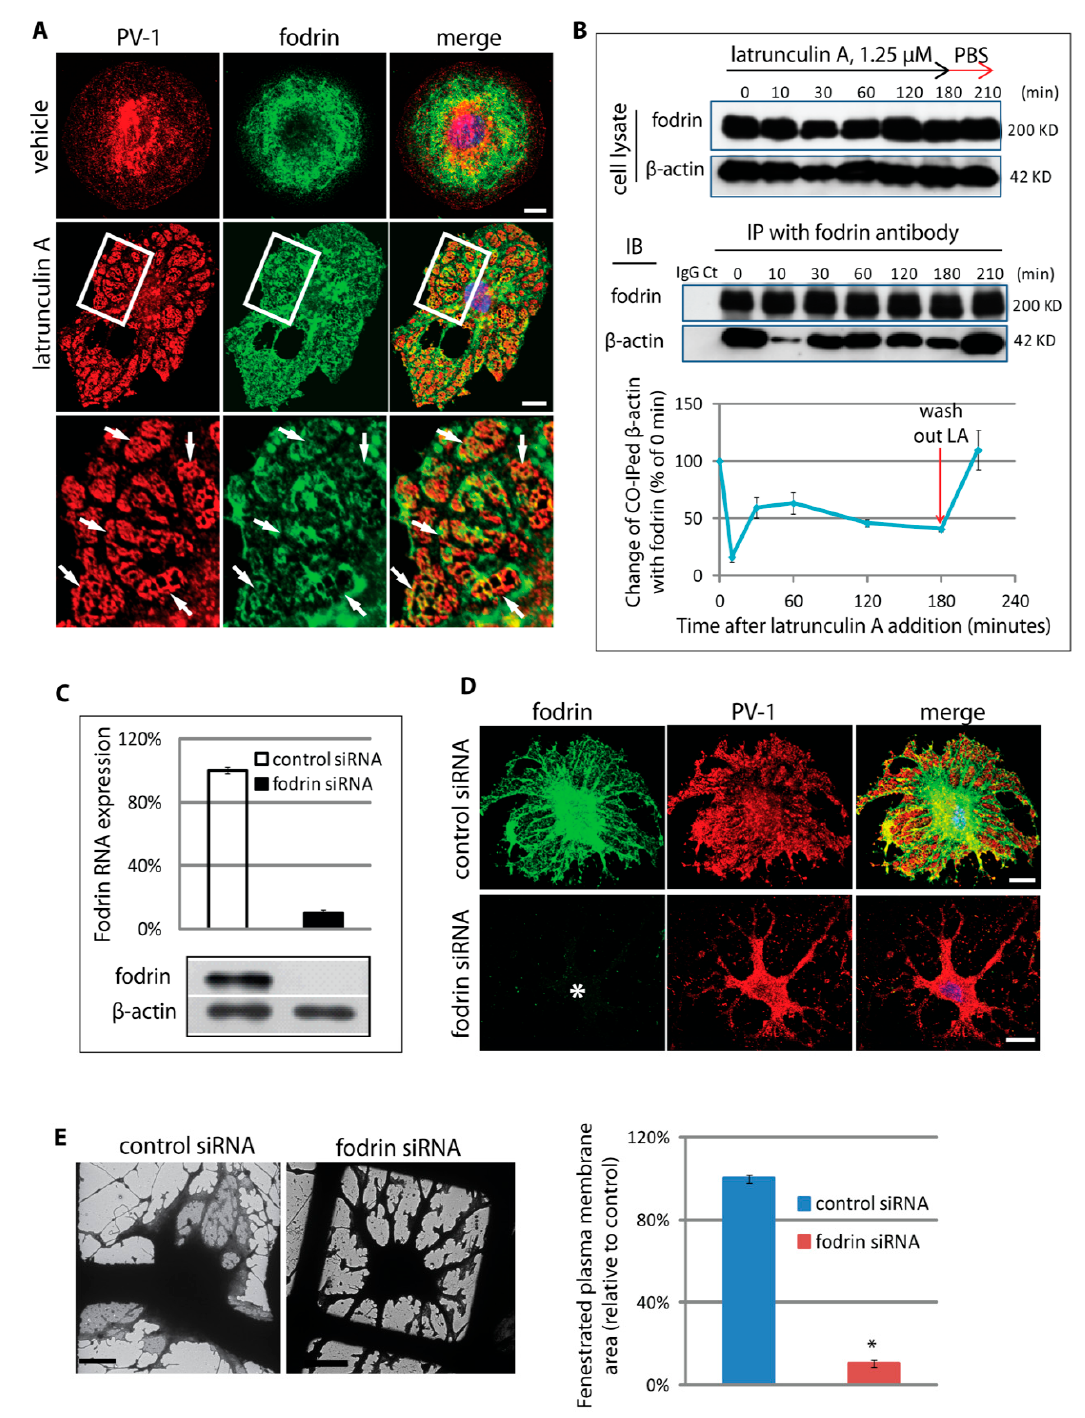
Figure 5. Fodrin is part of the sieve plate cytoskeleton and is required for fenestra formation. ( A ) Following fenestra induction, fodrin was reorganised into the PV-1-positive sieve plates (arrows, fenestral sieve plates; scale bar, 10 µ m). ( B ) Immunoprecipitation of fodrin revealed a dynamic interaction with β -actin during the time-course of fenestra induction, consistent with a redistribution of β -actin from large microfilament networks into the sieve plate fodrin cytoskeleton. The result of every time point is the average of 3 independent experiments ( n = 3). ( C ) Fodrin depletion in cells was achieved by siRNA transfection. Quantification based on triplicate experiments of fodrin in siRNA